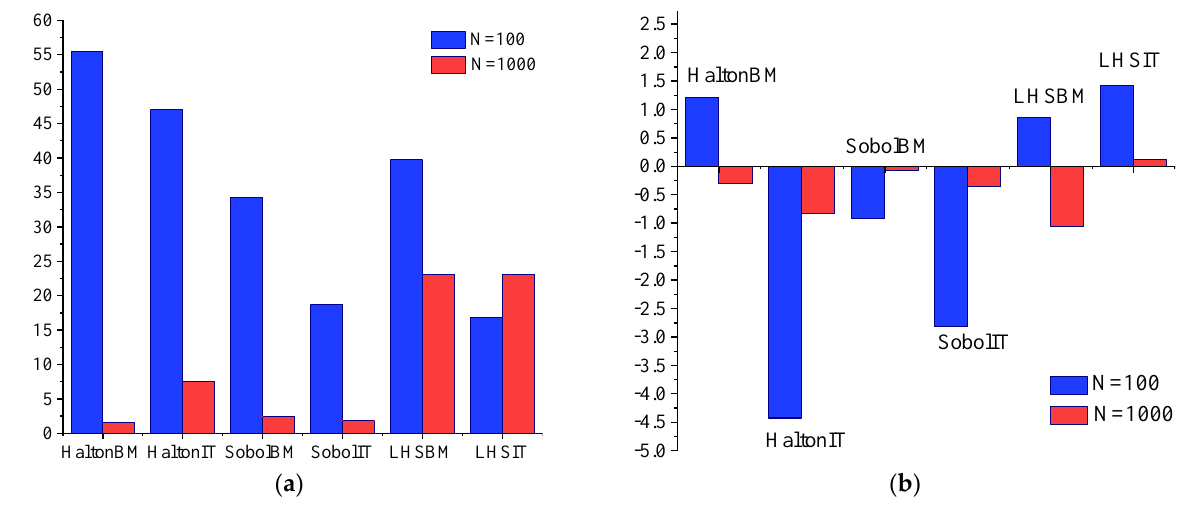
Figure 5. Maximum relative errors of sensitivity and failure probability when 𝑁 = 100 and 1000 in Example 2. ( a ) Maximum relative errors of sensitivity (%); ( b ) Maximum relative errors of failure probability (%). Table 4. Reliability and sensitivity results of different methods in Example 2 when 𝑁 = 100 .